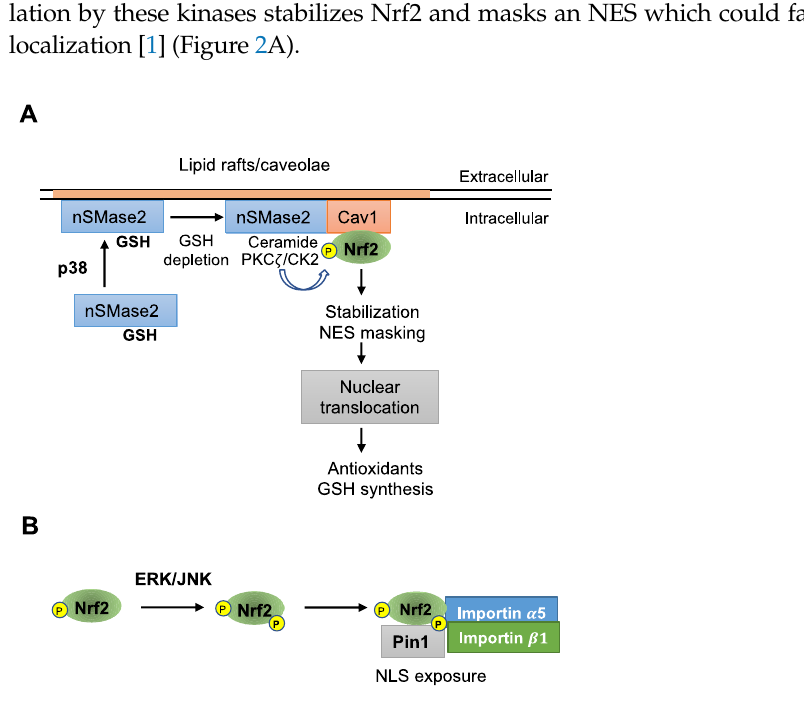
Figure 2. Stress-activated p38 controls nSMase2 activation, and ERK and JNK mediate Pin1-de- pendent Nrf2 nuclear translocation . ( A ) MAP kinase p38 induces the transfer of neutral sphingo-